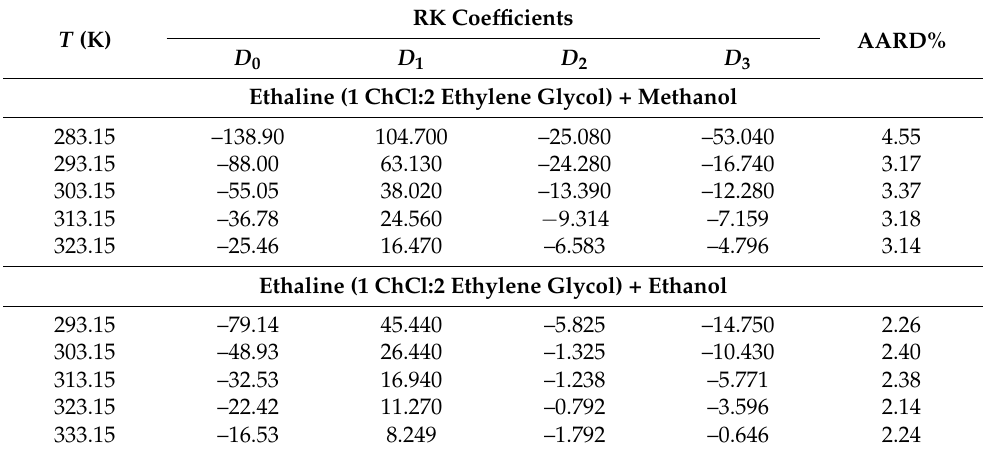
Table 7. The optimized values of the Redlich–Kister coefficients for the Ethaline + methanol/ethanol mixtures at various temperatures and at a pressure of 100 kPa. T